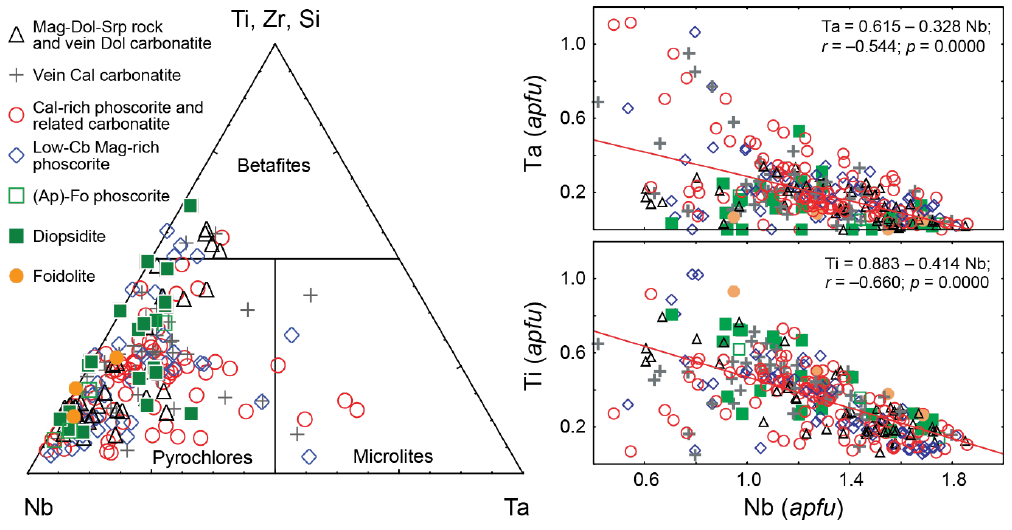
Figure 4. The Kovdor PSM classification diagram [11] and relations between Nb, Ta and Ti contents.